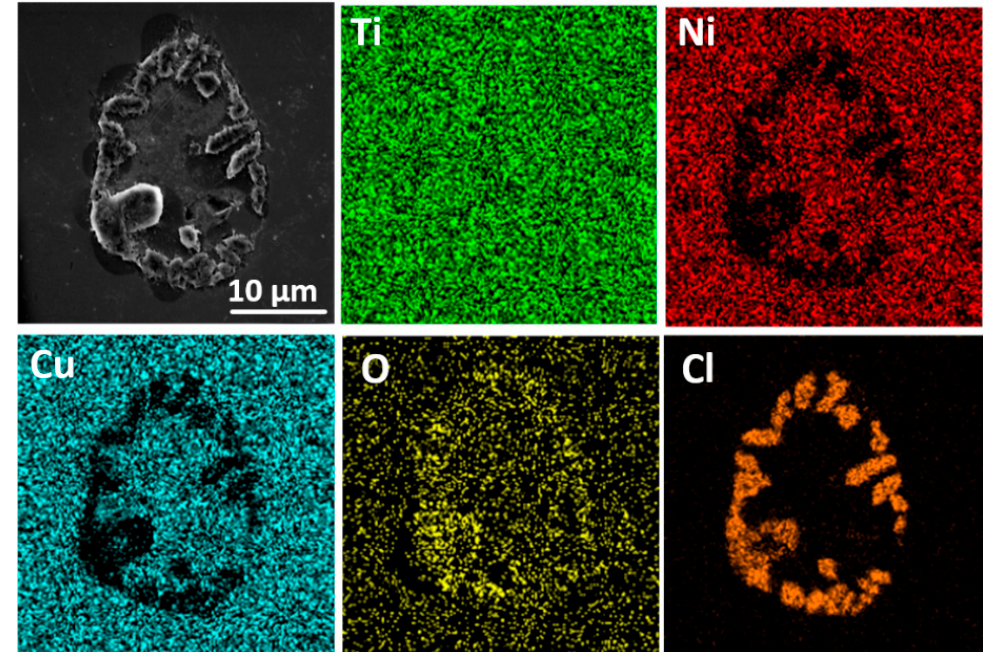
Figure 5. SEM and EDS mappings of Ti 40 Ni 40 Cu 20 BMGC wear surface in ASW. That is, the uncorroded region is covered with a uniform oxide film. In the corroded region and its surroundings, more O and Cl elements are enriched due to the newly formed TiO 2 and migrating Cl − . Ni and Cu have not participated in the corrosion process owing to the protection of the passive